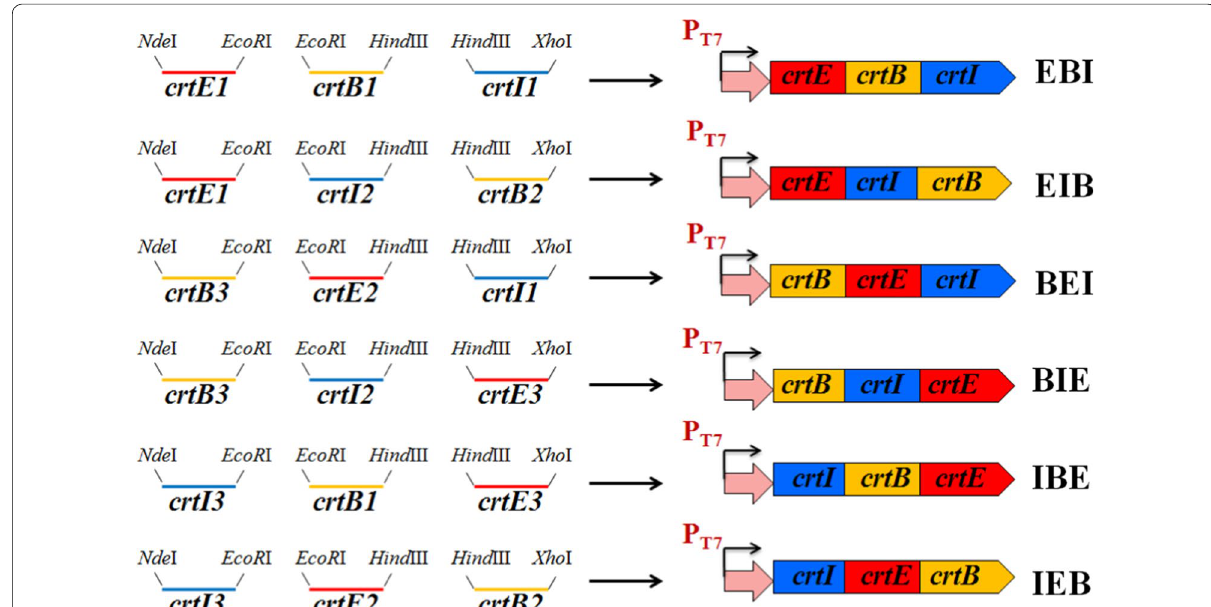
Fig. 2 Construction of recombinant plasmids with different gene order of crtE , crtB and crtI . The fragments crtE1 , crtE2 , crtE3 , crtB1 , crtB2 , crtB3 , crtI1 , crtI2 and crtI3 with different restriction enzyme sites were amplified and cloned into pET22b to form six recombinant plasmids with different gene orders of crtE , crtB and crtI . The termination codon TAA of the first and second genes was